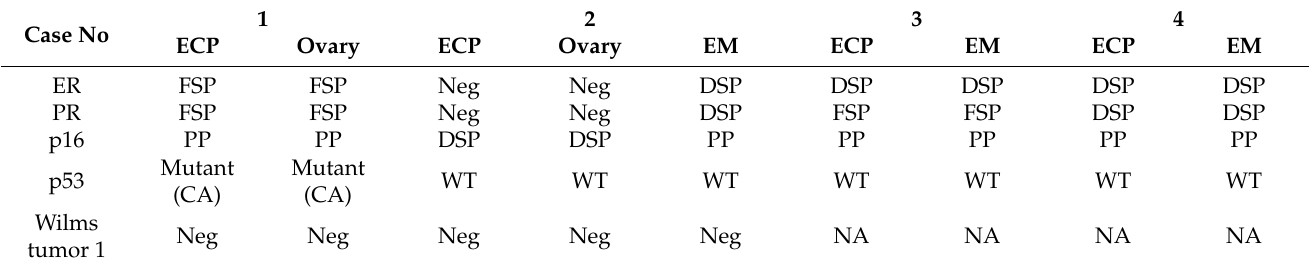
Table 3. The histological types and prevalence of gynecological tumors coexisting with